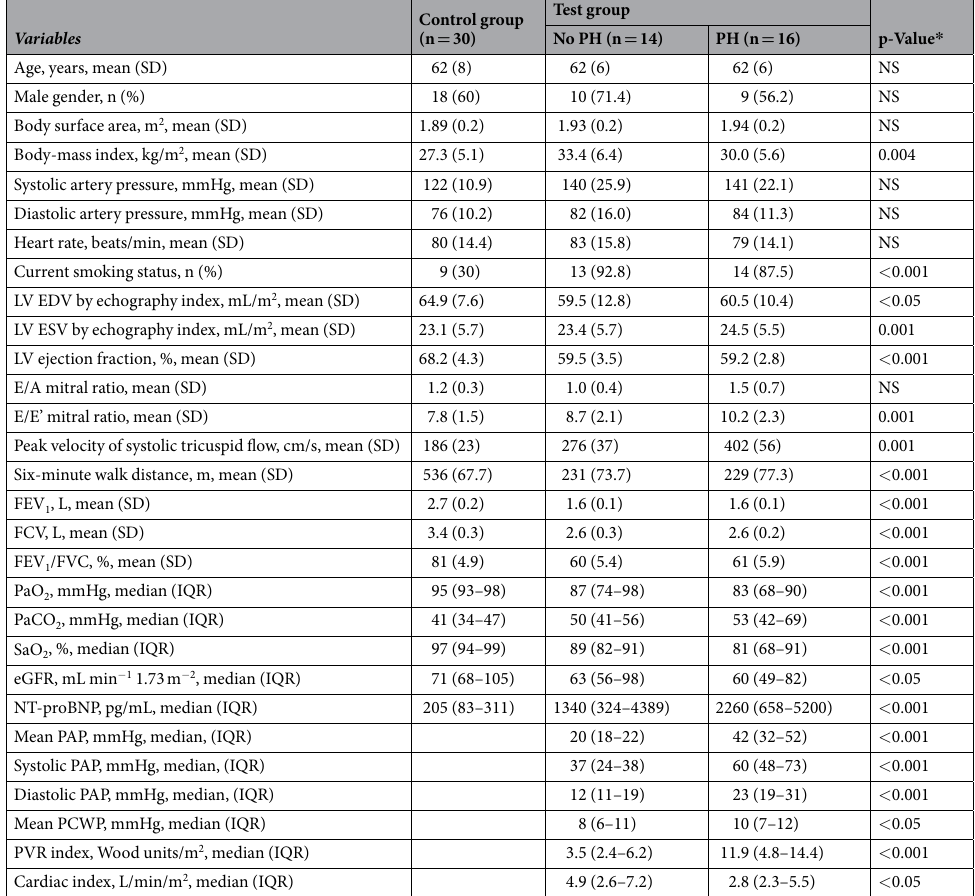
Table 1. Demographics, laboratory, echocardiography and hemodynamic characteristics of patients included in the study. Abbreviations: PH, pulmonary hypertension; LV, left ventricle; LVEDV, left ventricular end-diastolic volume; LVESV, left ventricular end-systolic volume; E/A mitral ratio, transmitral early diastolic velocity/ transmitral late diastolic velocity; E/E’ mitral ratio, transmitral early diastolic velocity/septal mitral annular early diastolic tissue velocity; FEV1, forced expiratory volume in 1 second; FVC, forced vital capacity; PAP, pulmonary artery pressure; PCWP, pulmonary capillary wedge pressure; PVR, pulmonary vascular resistance; PaO 2 , arterial partial pressure of oxygen; PaCO 2 , arterial partial pressure of carbon dioxide; SaO 2 , arterial oxygen saturation; eGFR, Estimated Glomerular Filtration Rate; NT-proBNP, N-terminal pro-B type natriuretic peptide; IQR, interquartile range; SD, standard deviation. * Represents statistical significance between